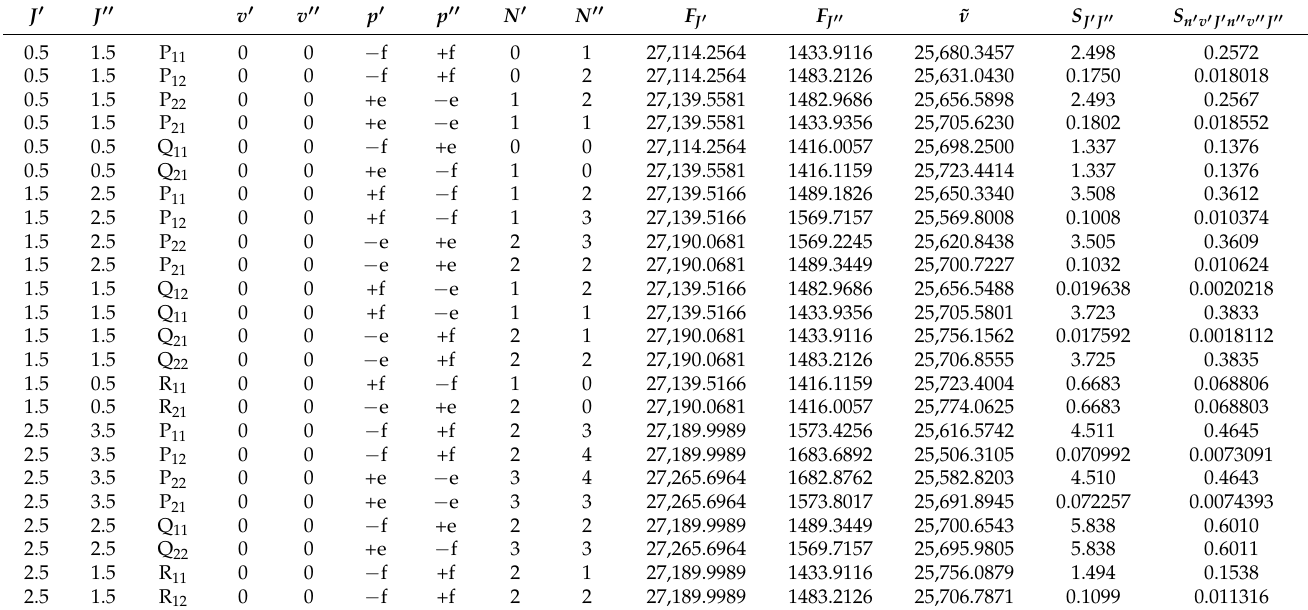
Table 2. First two dozen of 261 lines for the CH B 2 Σ − ↔ X 2 Π line strength table with column headings (identical to the ones in Table